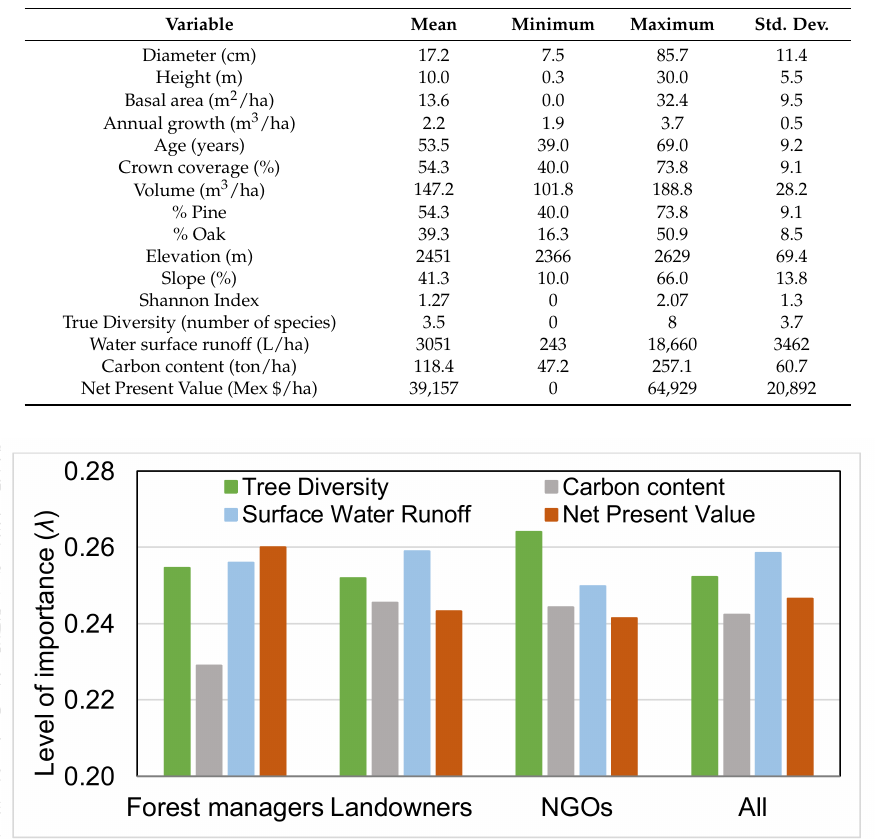
Table 1. Data description of the main variables used in the experimental plots in Molinillos, Durango.